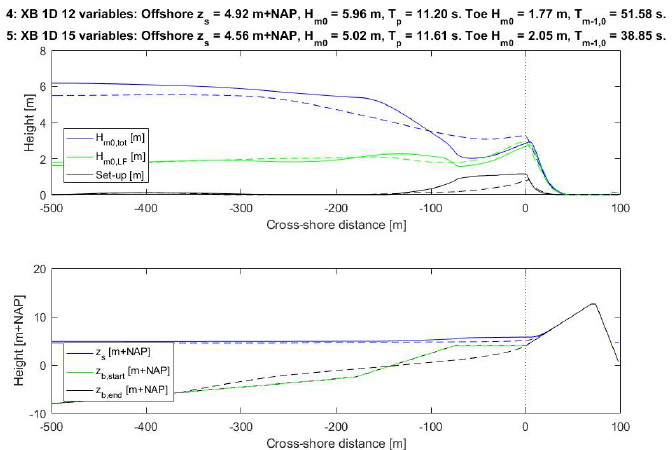
Figure 9. XBeach 1D with 12 stochastic variables and a morphostatic foreshore (solid lines) versus 15 stochastic variables and a morphodynamic foreshore (dashed lines), in the design point. The dike toe is again indicated by the dotted line. The parameters offshore and at the toe of the dike are given in the title of the figure.